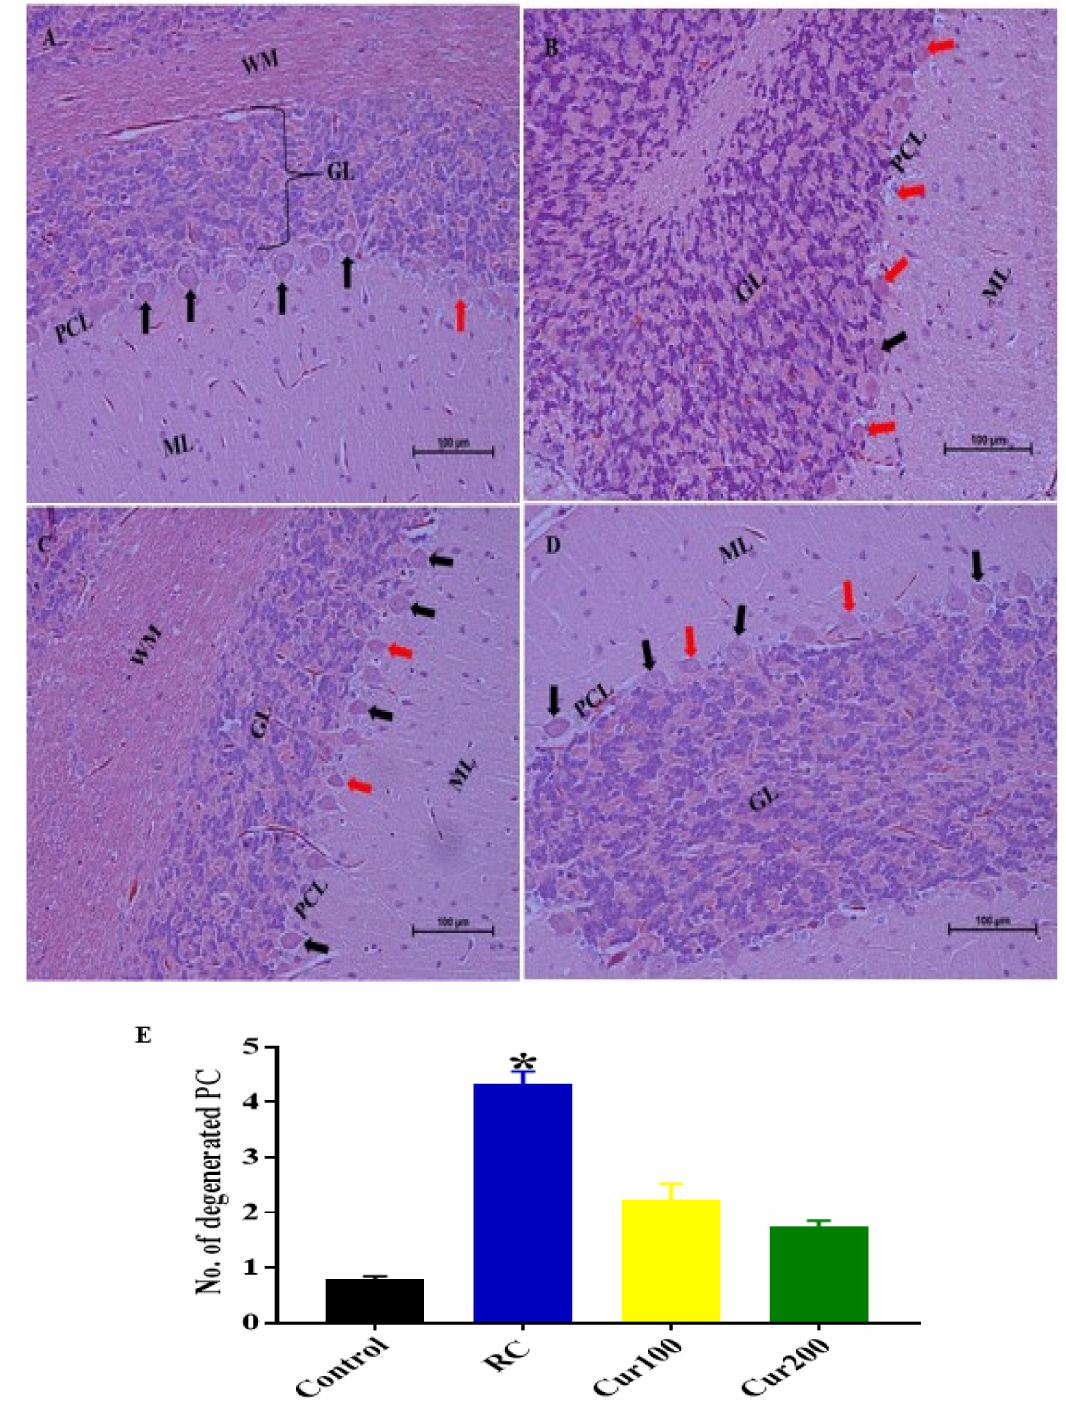
Figure 15. Photomicrograph sections of the cerebellums of the rat groups. ( A ) Control group indicating layers of the cerebellar cortex, the molecular layer (ML) with glial cells, the middle Purkinje cell layer (PCL) with the Purkinje cells having a large pyriform shape (black arrow), white matter (WM), and the inner granular layer with aggregation of granular cells (GL). ( B ) RC showing eosinophilic Purkinje cells withirregulardarkcytoplasm(redarrow)andscatteredglialcellsinthemolecularlayer(ML).( C )Cur100 showing the Purkinje cells with prominent nuclei and a regular shape (black arrow); the molecular and granular layers appear normal. ( D ) Cur200 showing normal pyriform-shaped Purkinje cells with prominent nuclei (black arrow) and normal granular and molecular layers. ( E ) Semi-quantitative representation of degenerated Purkinje cells in di ff erent rat groups. Data are represented as mean ± SEM ( n = 3); * p < 0.005 vs. control. H and E 200 × , scale bar = 100 µ